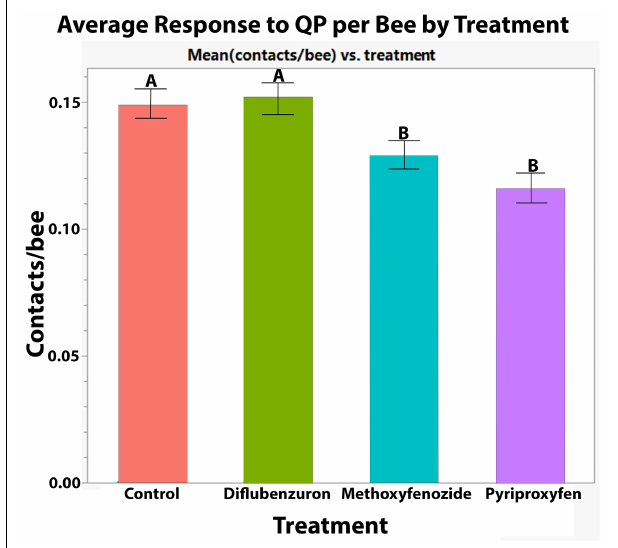
FIGURE 4 | Average ± S.E. number of contacts with QP lure per bee made by Apis mellifera workers in petri dish cages following developmental exposure to IGDs. Significance indicated by letters (GLMM, Tukey